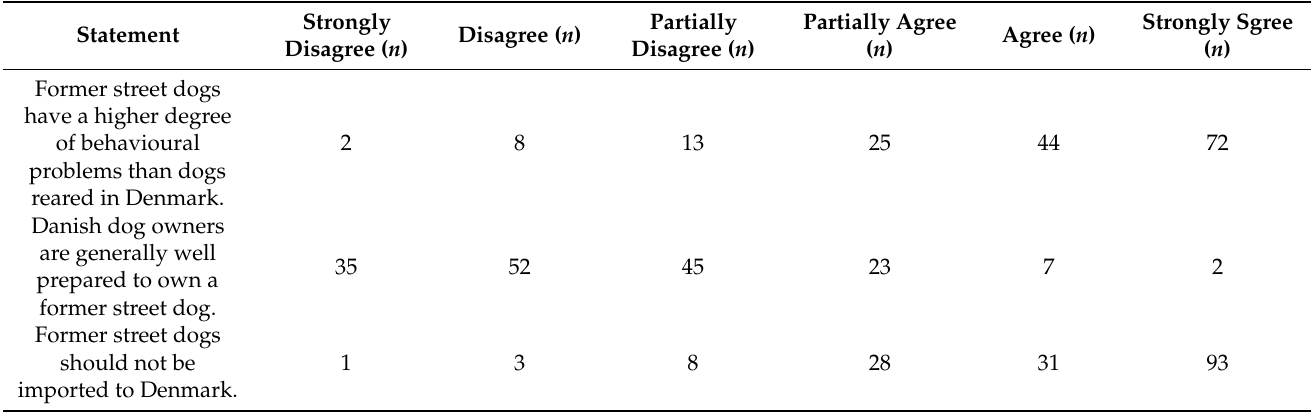
Table 3. The responses of 164 veterinarians asked to report their experience of behaviour in, and their general attitude to, former street (FS) dogs, on a 6-point